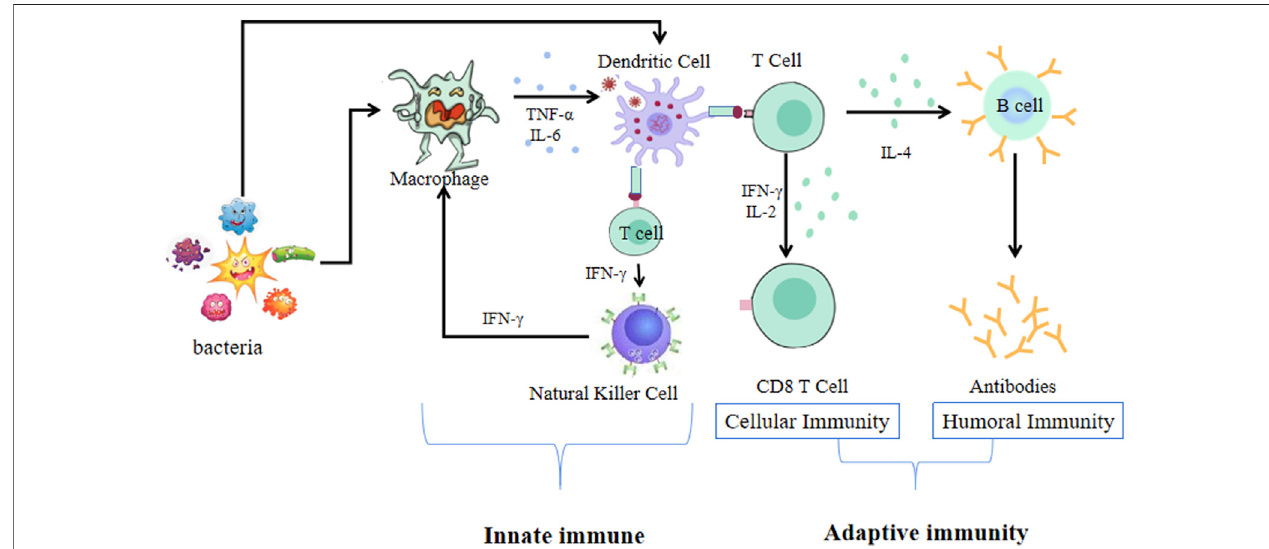
FIGURE 1 | The immune system of innate and adaptive